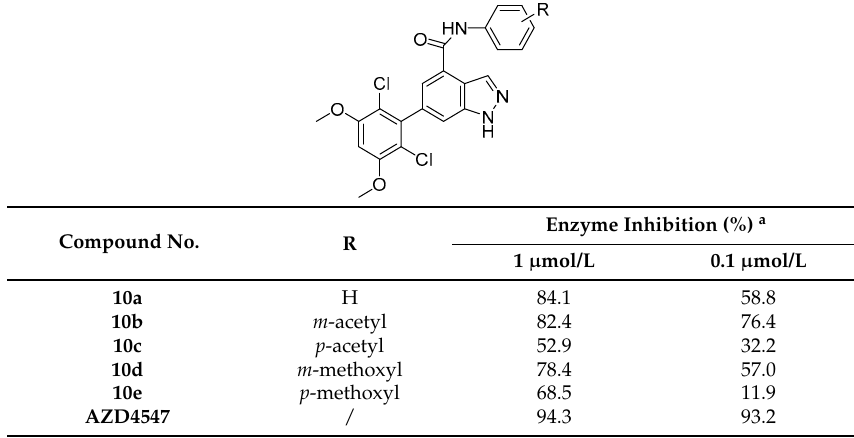
Table 1. Structures and activities of indazole derivatives 10a – e .